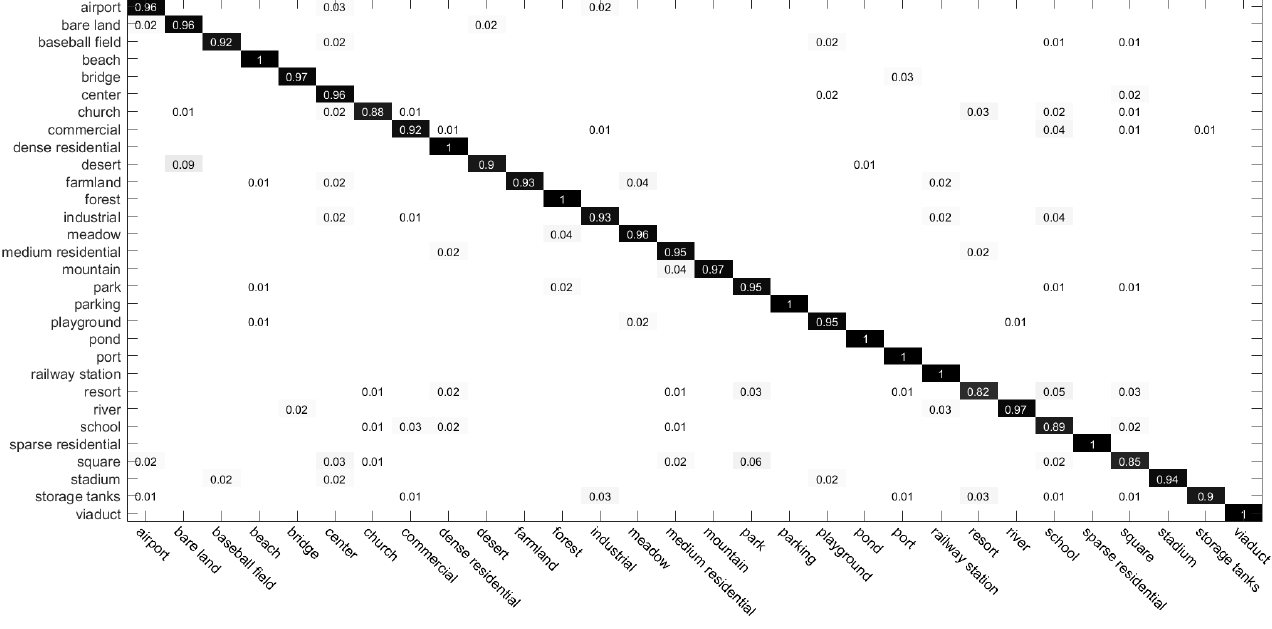
Figure 8. Confusion matrix of the proposed method on the AID dataset under the training ratio of